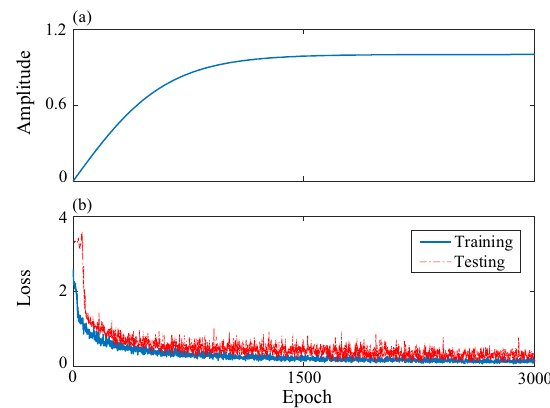
Fig. 7 Penalty parameter and loss of the proposed DTLN. ( a ) Penalty parameter. ( b ) Training and testing loss